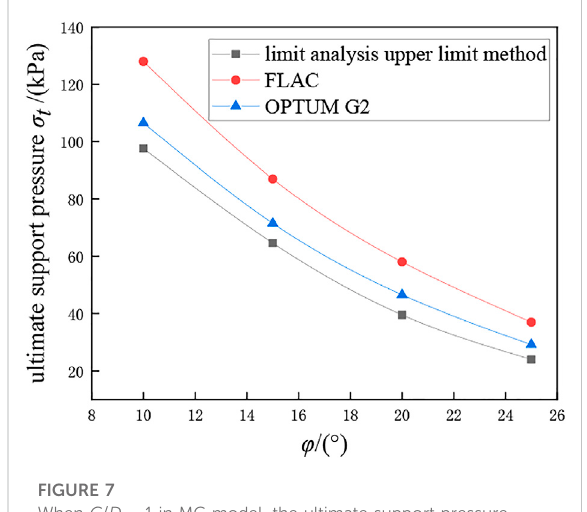
When C / D = 1 in MC model, the ultimate support pressure varies with friction.